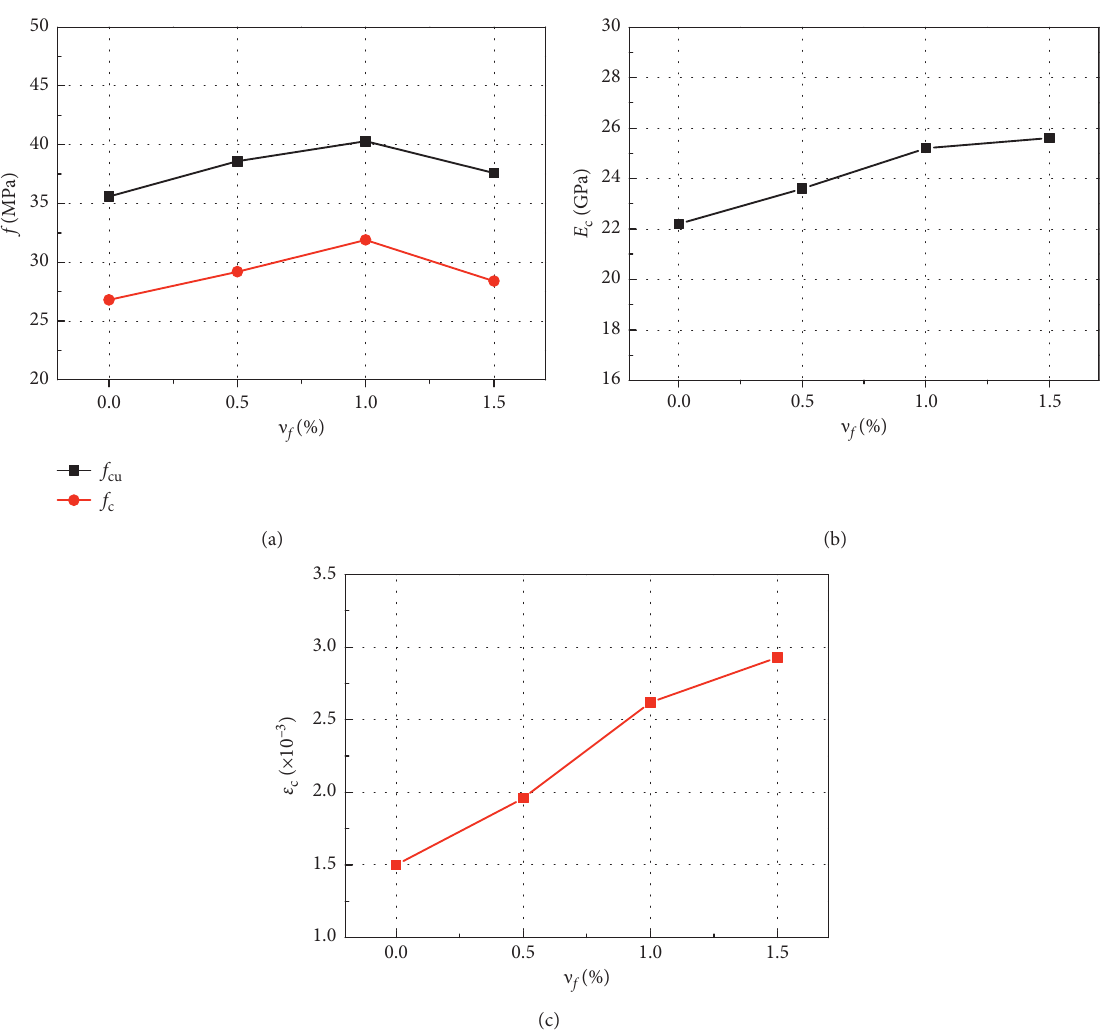
and f c ; (b) E ; (c) ε c . cu c